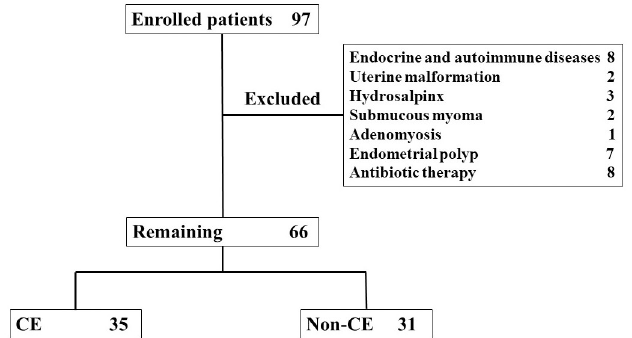
Fig 1. A total of 97 infertility patients who agreed to participate in the study at this time were included in the study. Out of these, 8 patients with endocrine and autoimmune diseases, 2 patients with uterine malformation, 3 patients with hydrosalpinx, 2 patients with submucous myoma, 1 patient with adenomyosis and 7 patients with endometrial polyps were excluded. Eight patients were excluded because of usage of antibiotics. As a result, 31 patients were excluded and 66 patients were included in the present study. CE was identified in 35 of 66 patients.